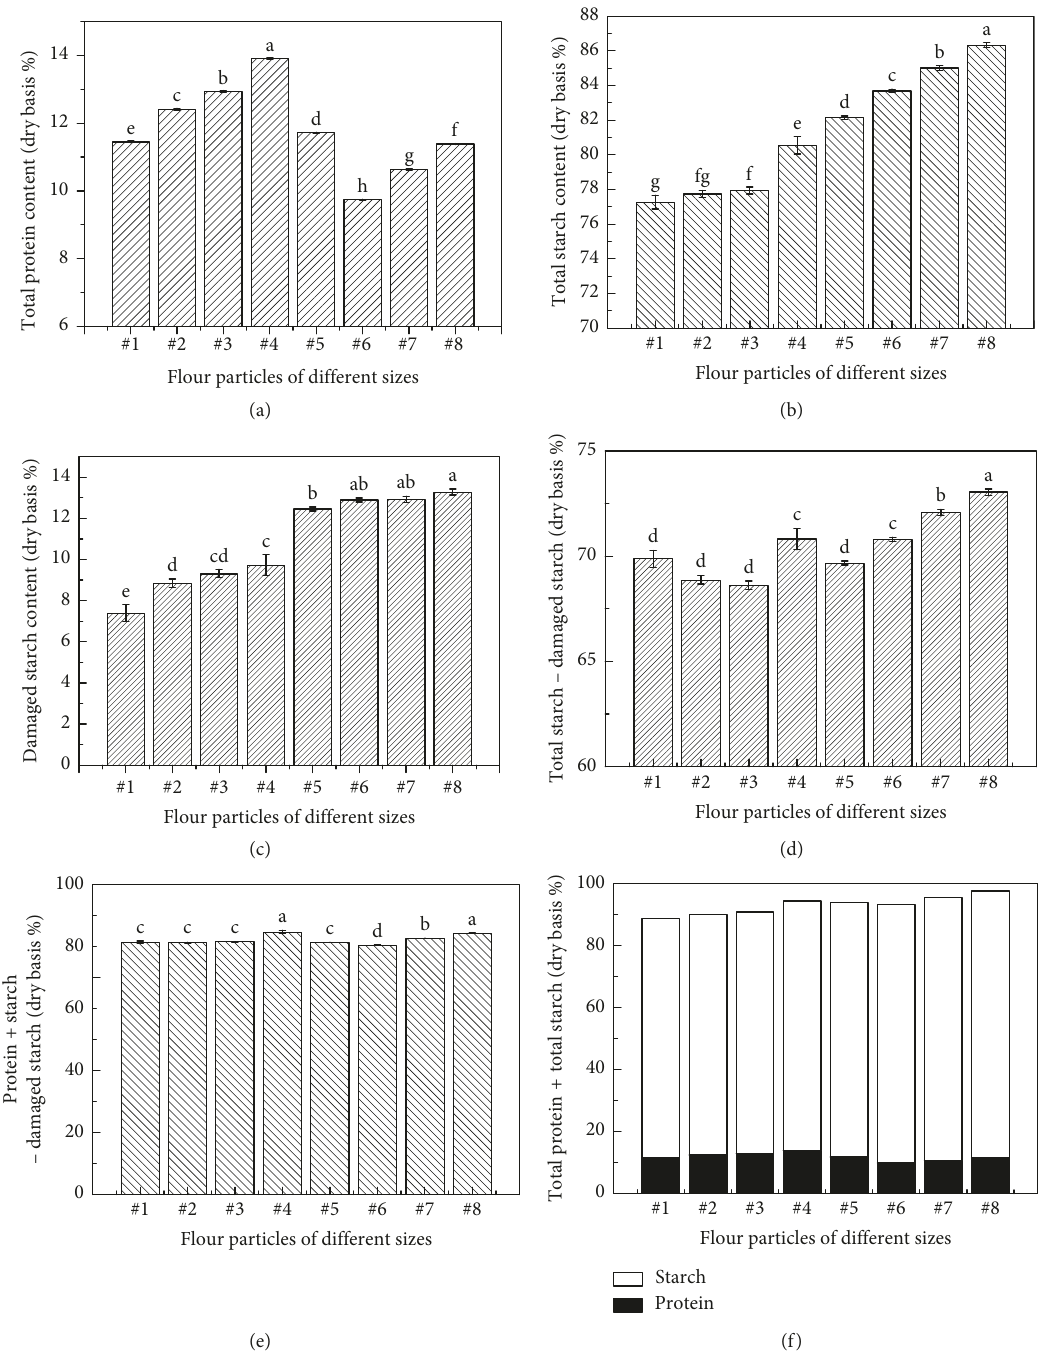
Figure 2: The protein and starch content of flour particles of different sizes. (a) total protein content; (b) total starch content; (c) damaged starch content; (d) integrated starch content (damaged starch subtracted); (e) total protein and integrated starch content (damaged starch subtracted); (f) total protein and total starch